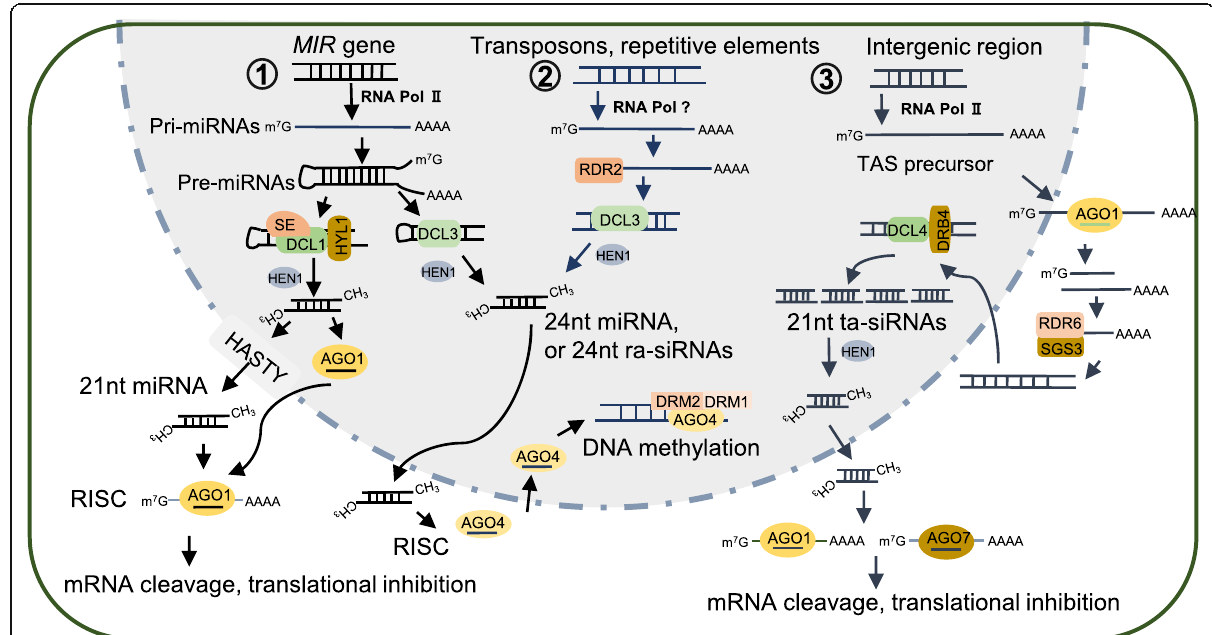
Fig. 1 A simple model describes the biosynthesis and assembly of small RNAs. ① MIR genes are transcribed by RNA Polymerase II (RNA Pol II) into primary miRNAs (pri-miRNAs). Pri-miRNAs form an imperfect fold-back structure and then are processed into a stem-loop-structured precursor miRNAs (pre-miRNAs). The pre-miRNAs are further processed into 21- or 24-nt miRNA duplexes by the complex that mainly includes DCL1 or DCL3, HYPONASTICLEAVES1(HYL1) and SERRATE (SE). The overhang ends of miRNA duplex are methylated by HUA ENHANCER 1 (HEN1) to increase stability and then one strand of the miRNA duplex is loaded into AGO proteins to form RNA-induced gene silencing complex (RISC) in the cytoplasm or the nucleus. The 21-nt miRNAs exploit two pathways to incorporate into AGO1 protein. One, the miRNA duplex is exported to the cytoplasm via HASTY channel, then one strand of the duplex is loaded into AGO1 to form RISC. Two, some 21-nt miRNAs could be directly loaded into AGO1 to form RISC in the nucleus and the RISC is exported to the cytoplasm. Then, the RISCs repress gene expression via mRNA cleavage, or translational inhibition. Besides, 24-nt miRNAs are loaded into AGO4 in the cytoplasm and reenter into the nucleus to mediate DNA methylation by recruiting DOMAINS REARRANGED METHYLTRANSFERASE (DRM). ② The transposons or repetitive elements are transcribed by an unknown RNA Polymerase (RNA Pol?), then these transcripts are used as templates by RDR2 to synthesize double stranded RNAs (dsRNAs). Later, the dsRNAs are processed into 24-nt repeat-associated siRNAs (ra-siRNAs) by DCL3 and are methylated by HEN1 at 3 ′ -terminal. Then one strand of ra-siRNAs is loaded into AGO4 to form RISC to mediate DNA methylation of target gene by recruiting the methyltransferases DRM1 and DRM2. ③ The specific intergenic regions are transcribed by RNA Pol II to generate the TAS precursors. The TAS precursors are targeted by some specific miRNA-AGO1 complex (such as miR390-AGO1 or miR173-AGO1) and are cleaved into fragments, then the 5 ′ or 3 ′ fragments of TAS precursors are exploited by RDR6 and SGS3 as the templates to synthesize the dsRNAs. The dsRNAs are imported into the nucleus and processed by DCL4 and DRB4 into 21-nt phased, trans-acting siRNAs (ta-siRNAs). After the methylation of ta-siRNAs at 3 ′ -terminal, ta-siRNAs are exported into the cytoplasm and one strand of the ta-siRNAs is loaded into AGO1 or AGO7 to form RISC to suppress gene